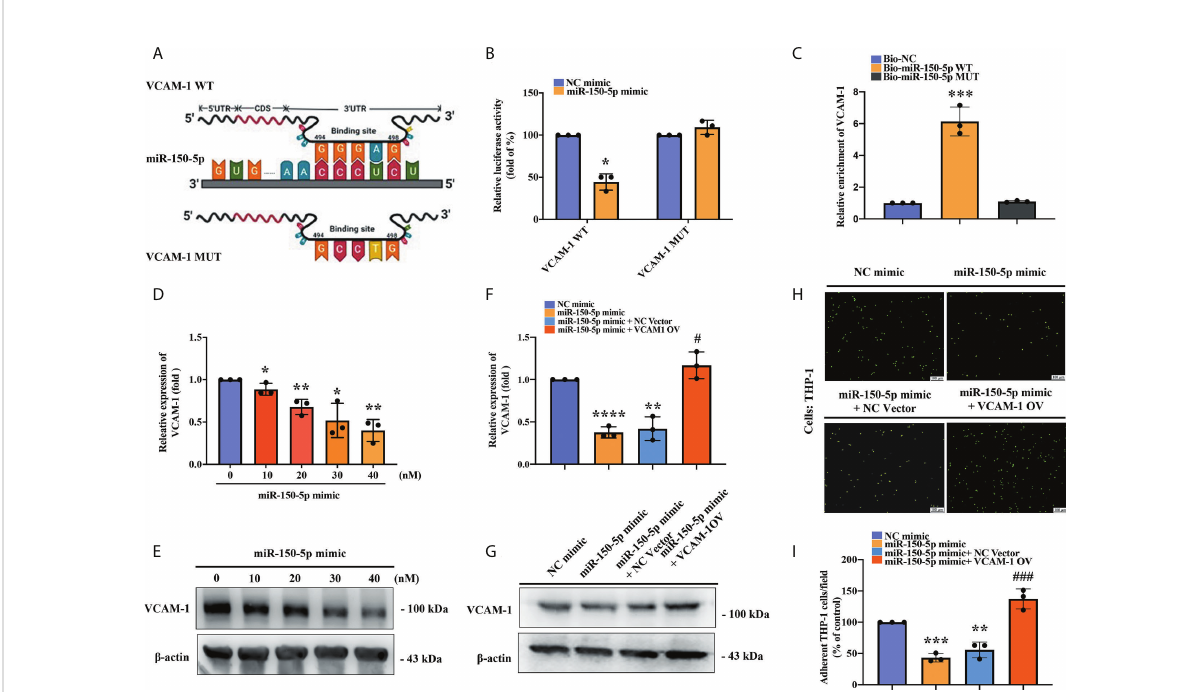
FIGURE 4 An interaction between miR-150-5p and VCAM-1 mitigates monocyte adherence in OASFs. (A) The schematic diagram shows the sequence binding site of miRNA-150-5p with VCAM-1 mRNA in miRWalk2.0. (B) The VCAM-1 WT plasmid and VCAM-1 MUT plasmid were each co- transfected with miRNA-150-5p mimic in OASFs for 24 h. Luciferase activities were measured and analyzed using the luminometer reader in three independent experiments. (C) After transfecting HEK-293 cells with each biotinylated probe, the lysed cells were incubated with M280 magnetic streptavidin beads (200 nM) for 4 – 6 (h) RNAs were isolated by TRIzol reagent, and levels of VCAM-1 expression were detected using RT-qPCR in samples pulled down by biotinylated miR-150-5p or negative control in three independent experiments. (D, E) OASFs were transfected with miR-150-5p mimic (0, 10, 20, 30, 40, or 50 nmol/L) for 24 h, and the levels of VCAM-1 expression were examined by RT-qPCR and Western blot in three independent experiments. (F, G) OASFs were co-transfected with miR-150-5p mimic and the VCAM-1 OV plasmid. VCAM-1 mRNA and protein levels were detected by RT-qPCR and Western blot in three independent experiments. (H, I) THP-1 cells were labeled with BCECF-AM and then incubated with OASFs for 1 h. The numbers of adherent cells were quali fi ed by Zeiss AxioPhot fl uorescence microscopy in three independent experiments. * p < 0.05, ** p < 0.01, *** p < 0.001, **** p < 0.0001 compared with control mimic; # p < 0.05, ### p < 0.001 compared with miR-150-5p